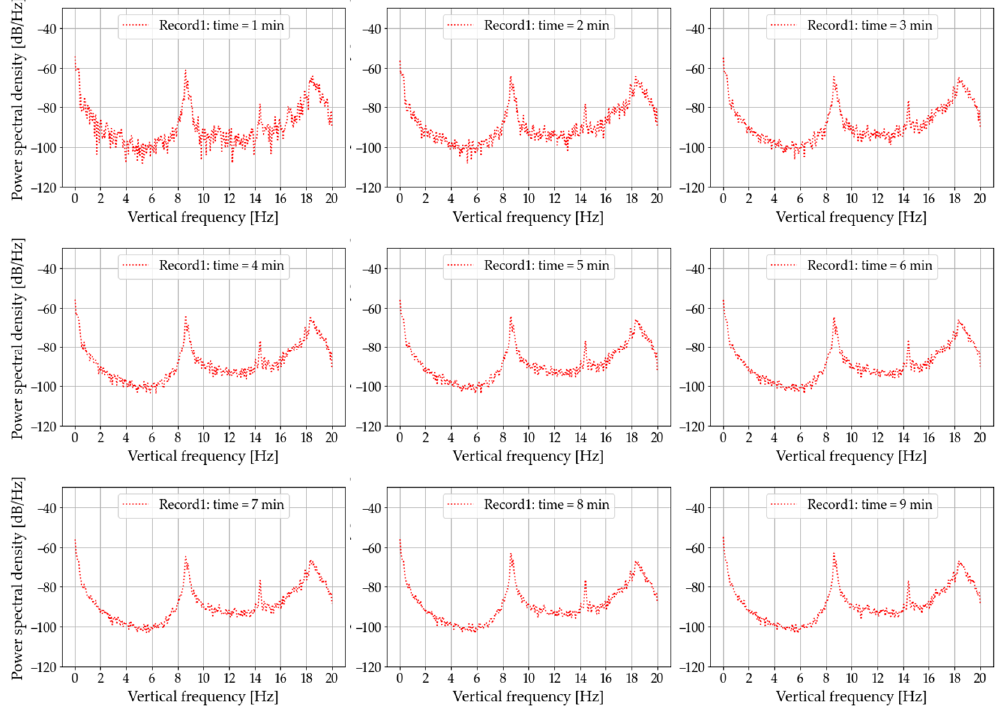
Figure 16. Power spectral density of the first nine vertical frequency observations of the Sagrado bridge.